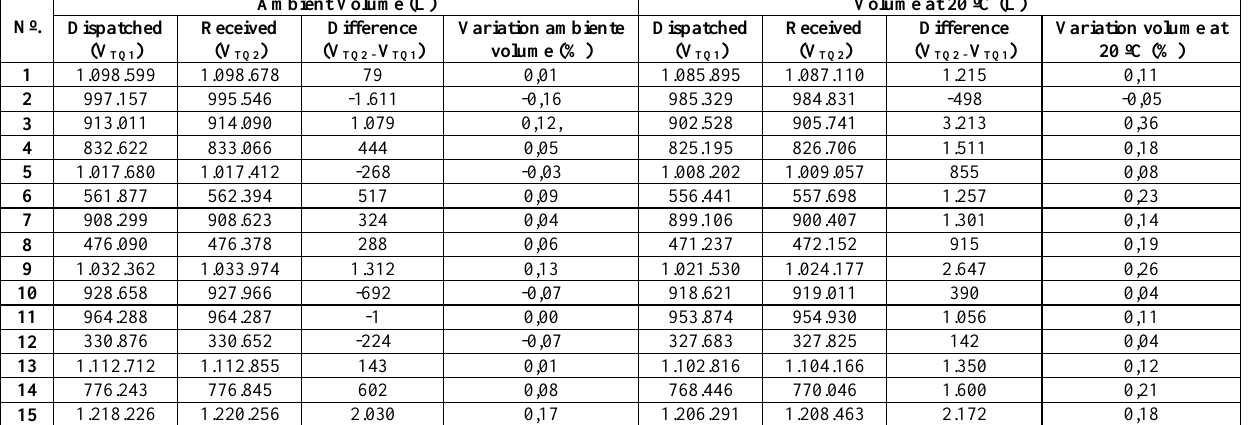
Table 5: Volume variation (%) in transfers between tanks (15 samples - October 2020 - process review). Nº.